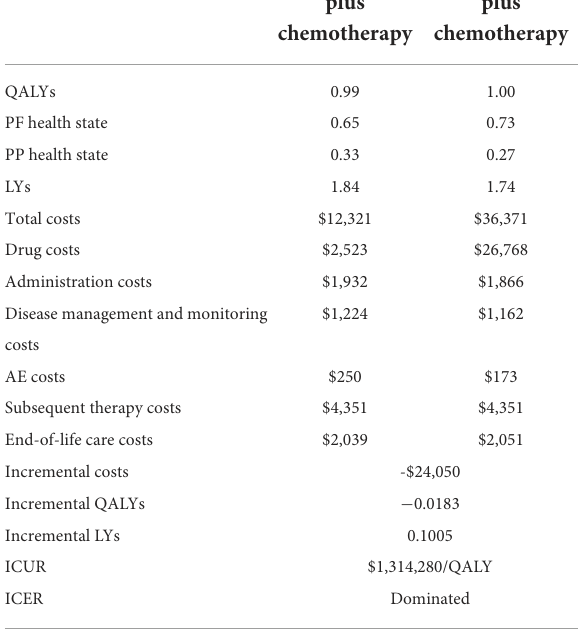
TABLE 5 Summary of the cost and health outcomes